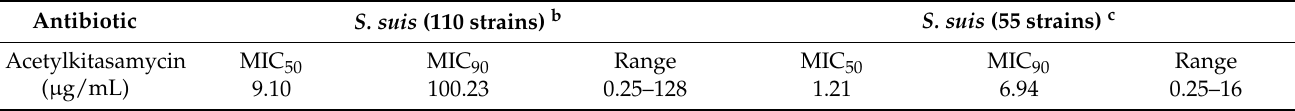
Table 3. Susceptibilities of isolated S. suis strains.